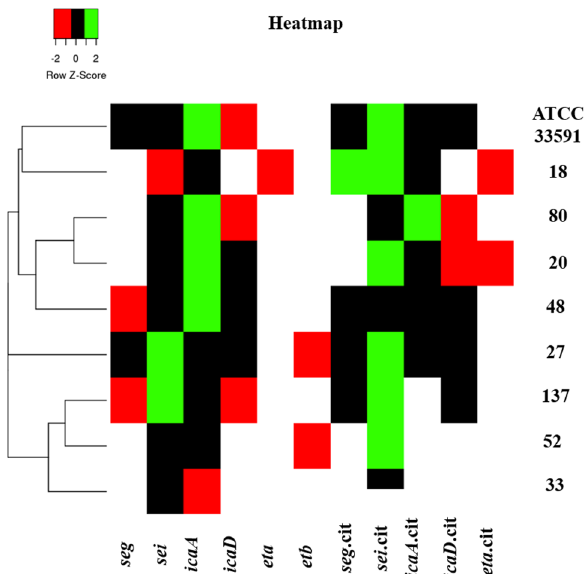
Figure 5. Heatmapper platform formed four clusters according of differentially expressed virulence genes seg , sei , icaA , icaD, eta and etb of MRSA strains (18, 20, 27, 33, 48, 52, 80, 137) and ATCC 33591 control and with 2.5% citral treatment. The green segments in the plot represent greater differential expression and the red segments represent less modulation, comparing different genes and treatment with